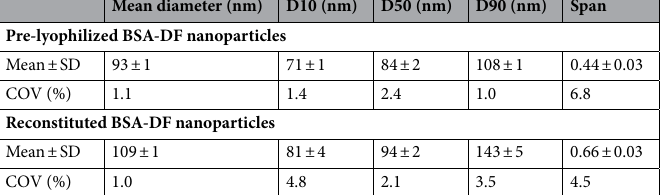
Table 1. Nanoparticle tracking assessment of BSA-DF and freeze dried/reconstituted BSA-DF nanoparticles from multiple fabrication lots (3). SD standard deviation of the